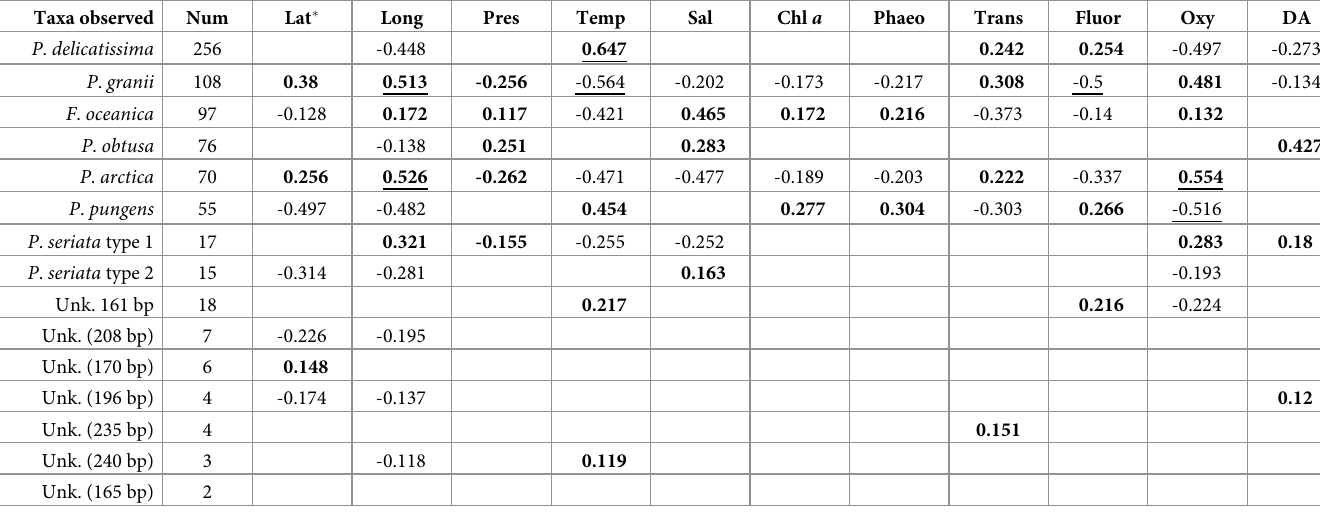
Table 4. Summary of Spearman’s correlation coefficients (rho) between various environmental factors and selected diatom species from both surveys. Taxa